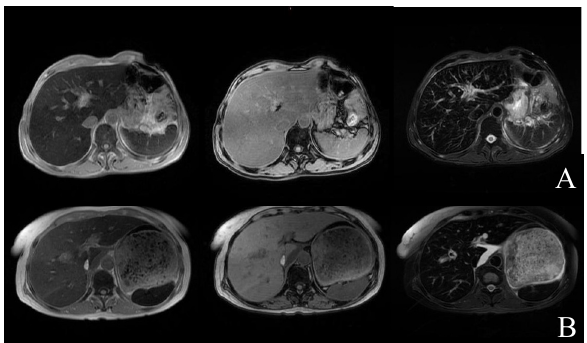
Figure 2. A was a MRI image of the same patient with T1WI positive phase, T1WI inverse phase and T2WI sequence images. Both the positive and inverse phase of T1WI and the signal of T2WI liver were decreased, showing "black liver", and the decrease of T2WI signal was more significant. At the same time, the inverse phase signal on T1WI was higher than the positive phase signal of T1WI, is contrary to fatty liver ； B was another case of MRI imaging, and the signal of each sequence was the same as A.